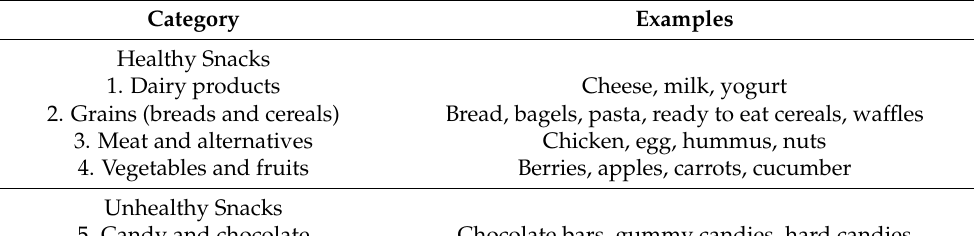
Table 2. Examples of the most common food items in the eleven distinct categories of snacks.